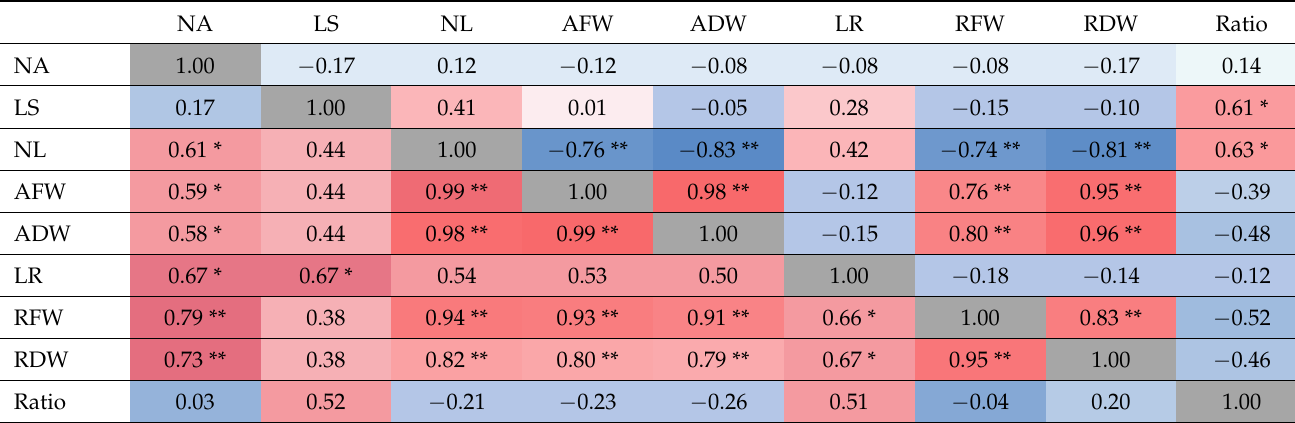
Table 4. Matrices of correlations between measured traits for the studied lines of M. truncatula under control treatment (down diagonal) and 30% of field capacity (up diagonal).